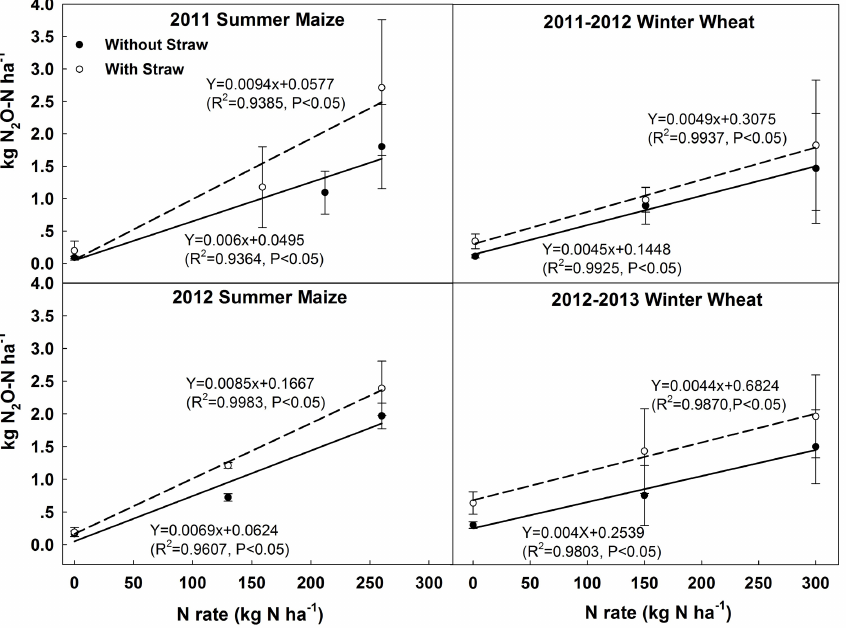
Fig. 4. Correlations between seasonal cumulative N 2 O emissions and fertilizer N application rates from 2011 to 2013. The dashed line and solid line were fitted by linear regression from the straw and without straw treatments,